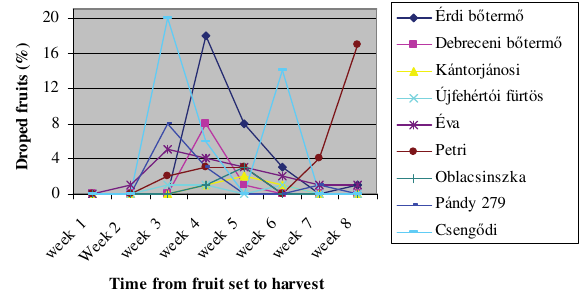
Figure 3. Seasonal changes of fruit drop of 9 sour cherry cultivars Érdi